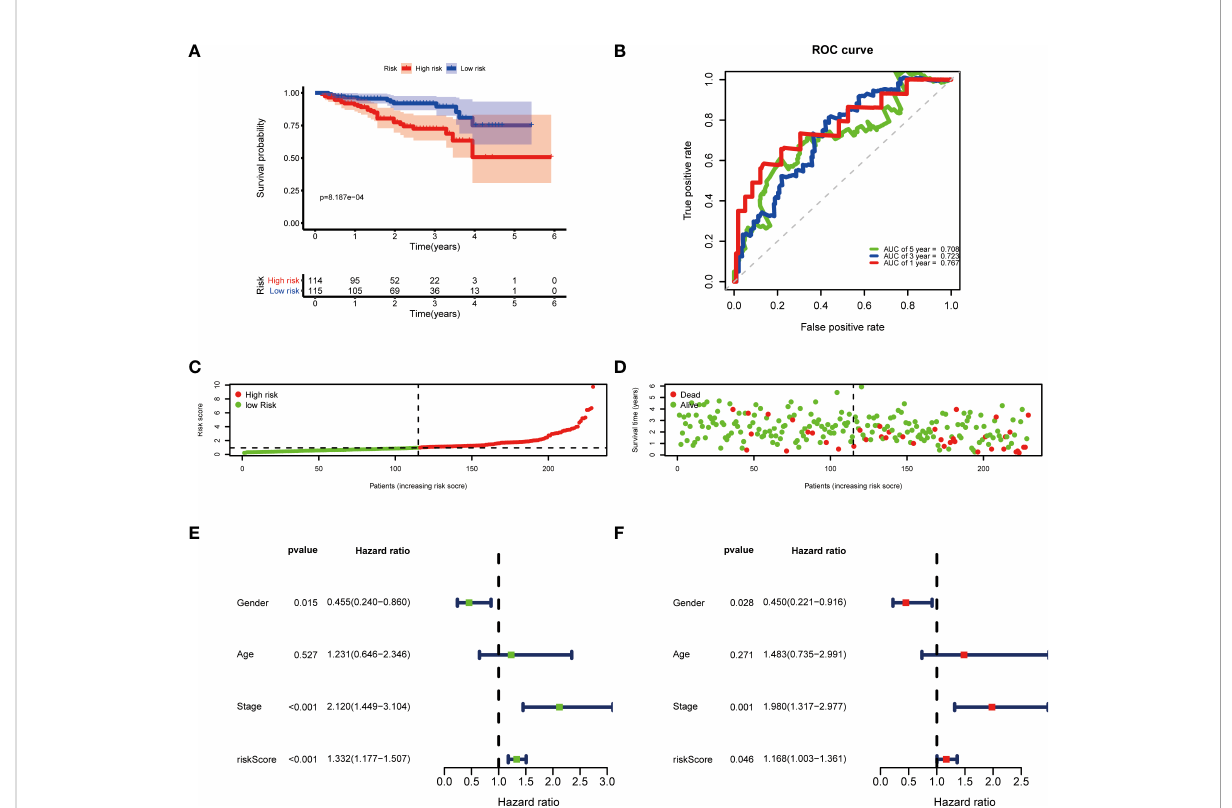
FIGURE 4 Validation of the prognostic model in the ICGC cohort. (A) Kaplan-Meier survival analysis between the high- and low-risk patients. (B) Time- dependent ROC curves at 1,3,5-years. (C) Distribution of risk scores, (D) survival status of each patient. (E) Univariate and (F) multivariate Cox regression